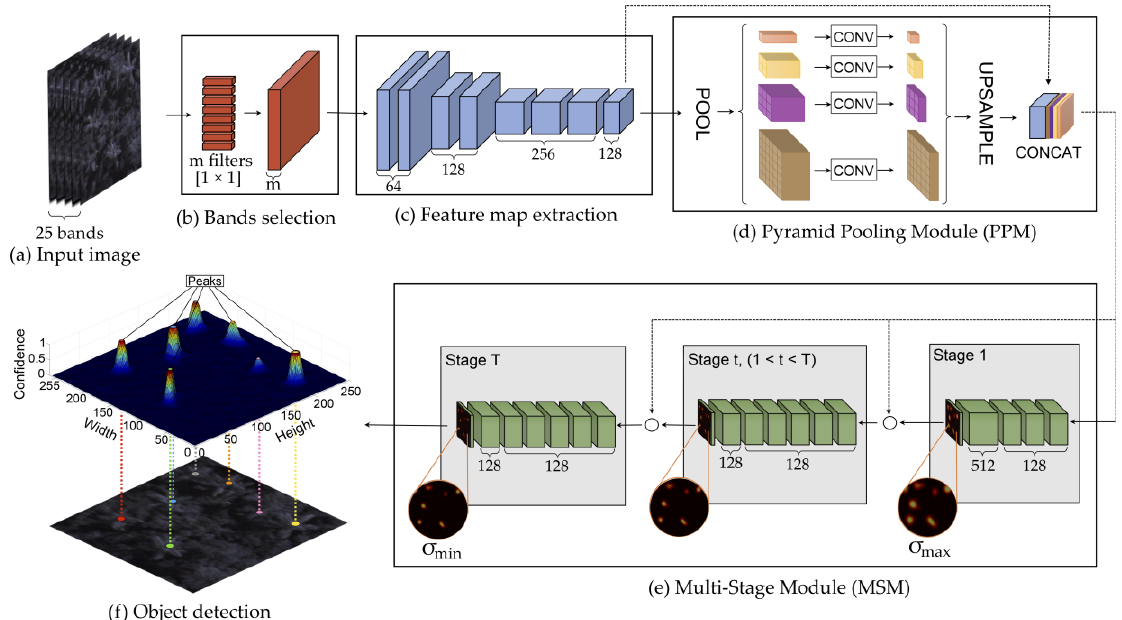
Figure 2. Proposed method for tree detection. The first module ( b ) is responsible for learning m bands from the input image ( a ). The initial part ( c ) obtains a feature map from the input image and it is enhanced by the PPM ( d ). The resulting volume is used as input to the MSM ( e ). The T stages refine prediction positions until trees ( f ) are detected.